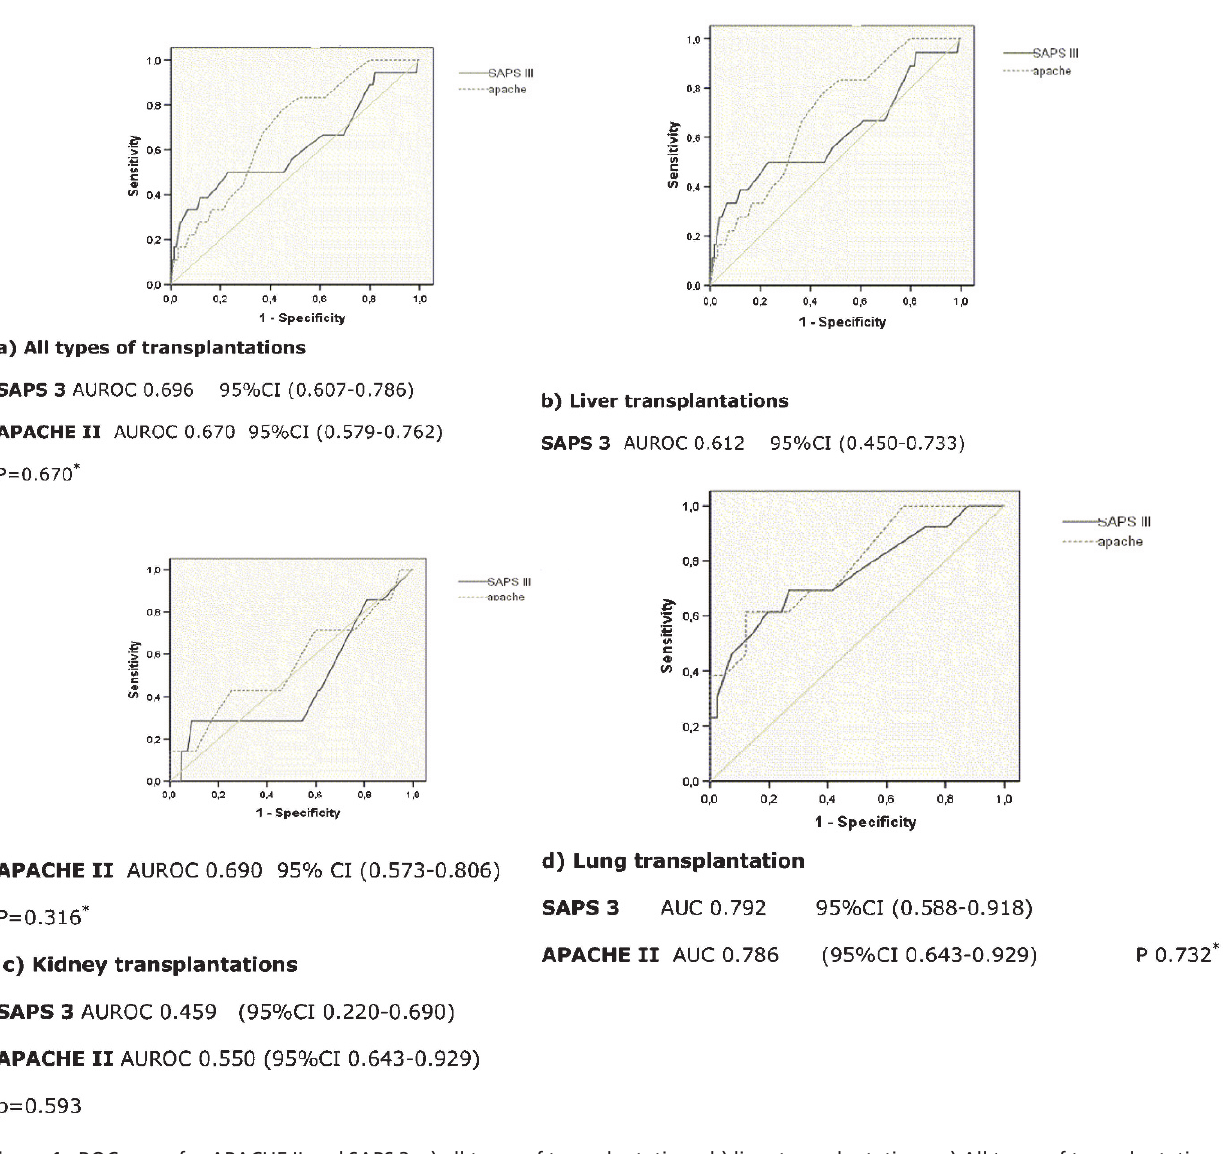
Figure 1 - ROC curve for APACHE II and SAPS 3: a) all types of transplantations; b) liver transplantations; a) All types of transplantations. SAPS 3 AUROC 0.696 95%CI (0.607-0.786) APACHE II AUROC 0.670 95%CI (0.579-0.762) P=0.670 * . b) Liver transplantations. SAPS 3 AUROC 0.612 95%CI (0.450-0.733).